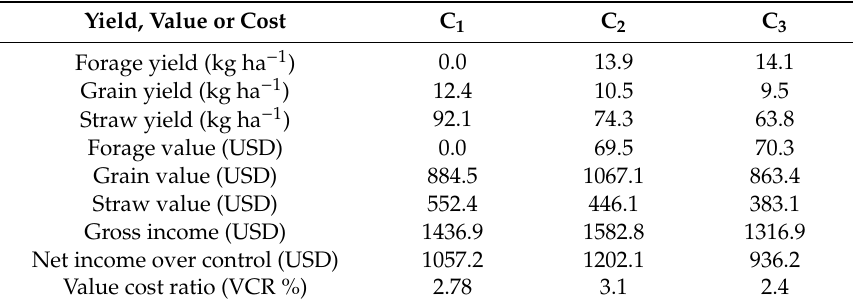
Table 9. Economic analysis of dual-purpose canola.